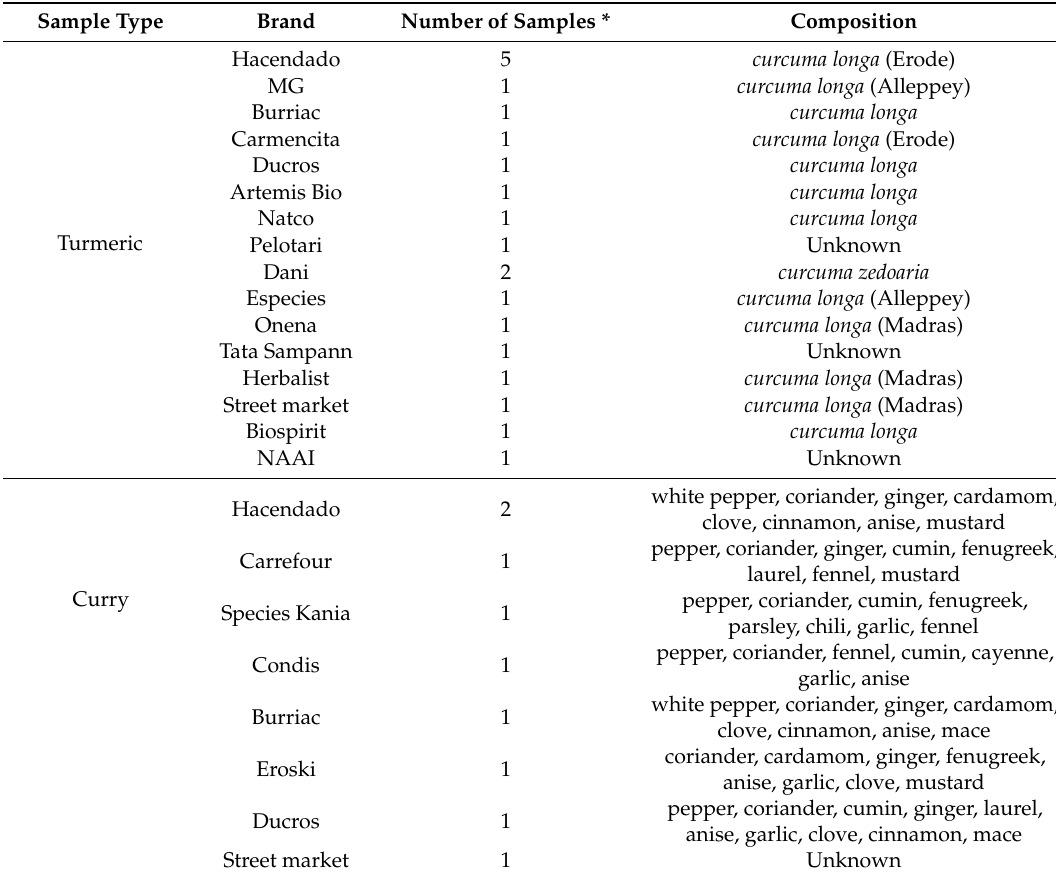
Table 1. List of samples analyzed and their